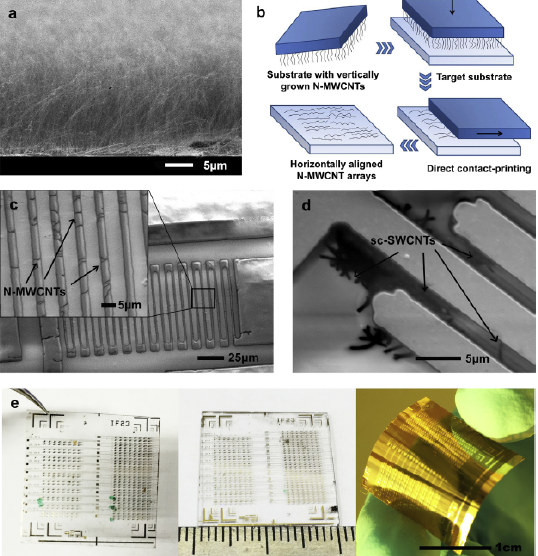
Figure 22. ( a ) Scanning electron micrographs of close-packed vertical arrays of N-MWCNTs grown on a Si/SiO2 substrate with CVD. ( b ) Sketch of the contact-printing process for vertically aligned CNTs. ( c ) SEM image of N-MWCNT based chemiresistor sensor device on Kapton® substrate; the higher magnified image in the inset shows a regular array of horizontally aligned N-MWCNTs bridging Cr/Au interdigitated electrodes. ( d ) Low-voltage SEM image of patterned Cr/Au interdigitated electrodes on quartz substrate bridged with sc-SWCNTs. ( e ) Optical images of CNT chemiresistor biosensor chips each containing 400 sensing devices fabricated on various substrates (from left to right: quartz, glass and Kapton® polyimide film)